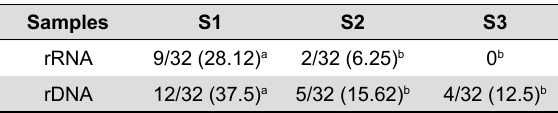
Table 1- Number of positive PCR results for streptococci in samples taken before (S1) and after (S2) root canal preparation, and after calcium hydroxide medication (S3), using rRNA- and rDNA-based PCR assays